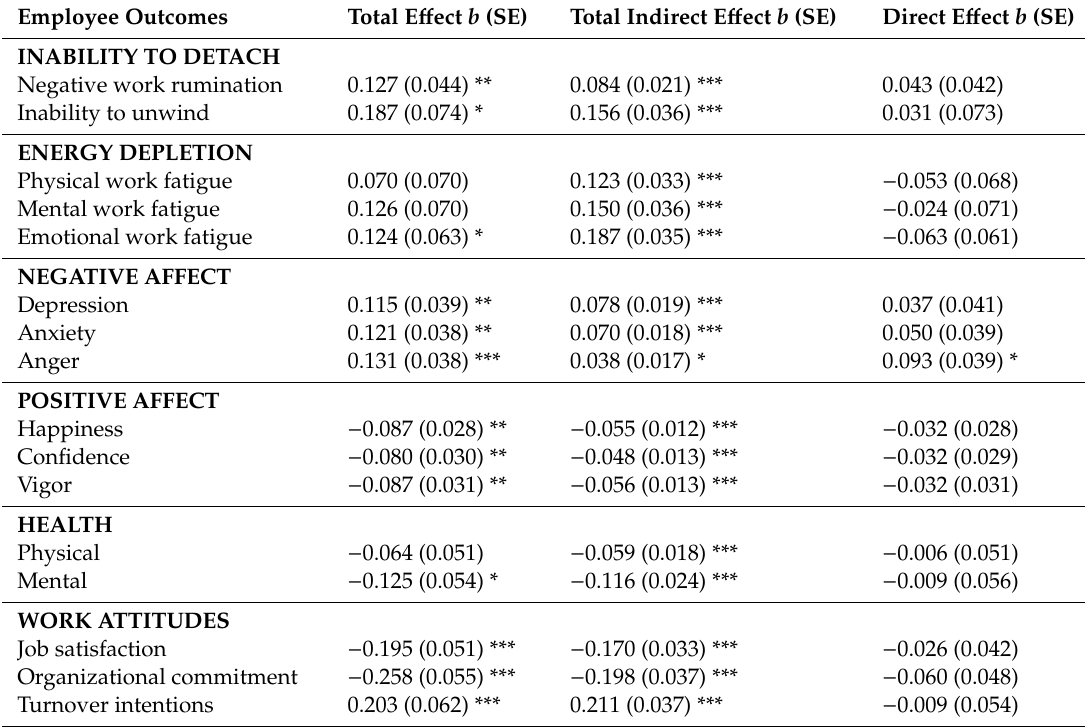
Table 3. Unstandardized total e ff ects, total indirect e ff ects, and direct e ff ects of organizational downsizing on employee outcomes